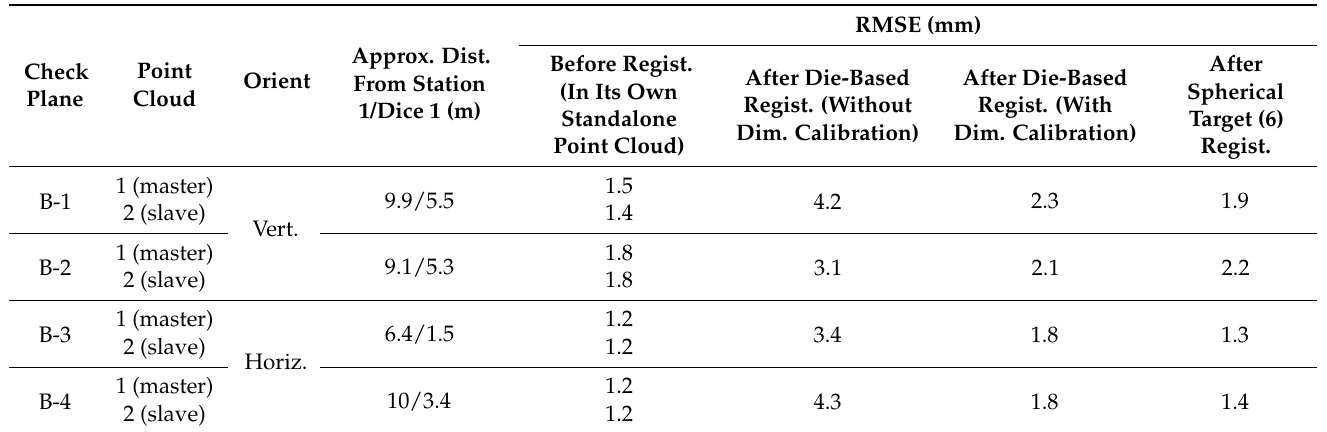
Table 3. RMSEs of check plane residuals before and after the registration. (Dataset B, die dimension = 50 cm × 50 cm × 50 cm).